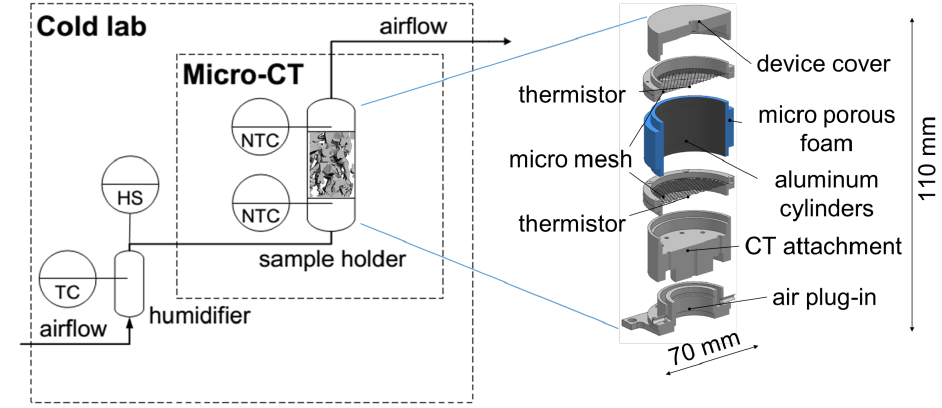
Figure 1. Schematic of the experimental setup and the sample holder. A thermocouple (TC) and a humidifier sensor (HS) inside the humidifier measured the airflow conditions. Two thermistors (NTC) close to the snow surface measured the inlet and outlet temperature of the airflow (Ebner et al., 2014). Table 1. Morphological and flow characteristics of the experiments: volume flow ( ˙ V ), corresponding Peclet number ( Pe ), Reynolds number ( Re ), initial superficial velocity in snow ( u D,0 ), initial snow density ( ρ 0 ), initial porosity ( ε 0 ), specific surface area (SSA 0 ), initial pore diameter ( d p ), temperature in the cold laboratory ( T lab ), and the sintering time of the